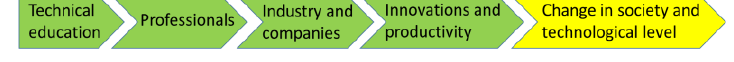
Fig. 4. Knowledge transfer principle [6], [16],